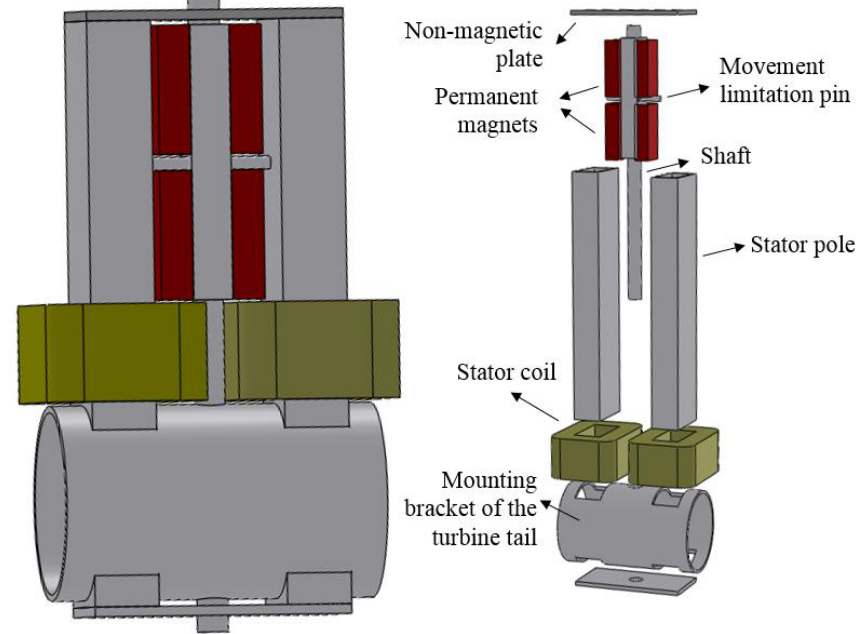
Figure 1. Structure of the limited-angle torque (LAT) actuator.